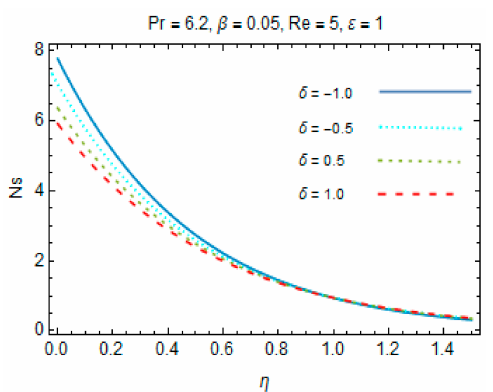
Figure 10. Variation in Ns against ε .